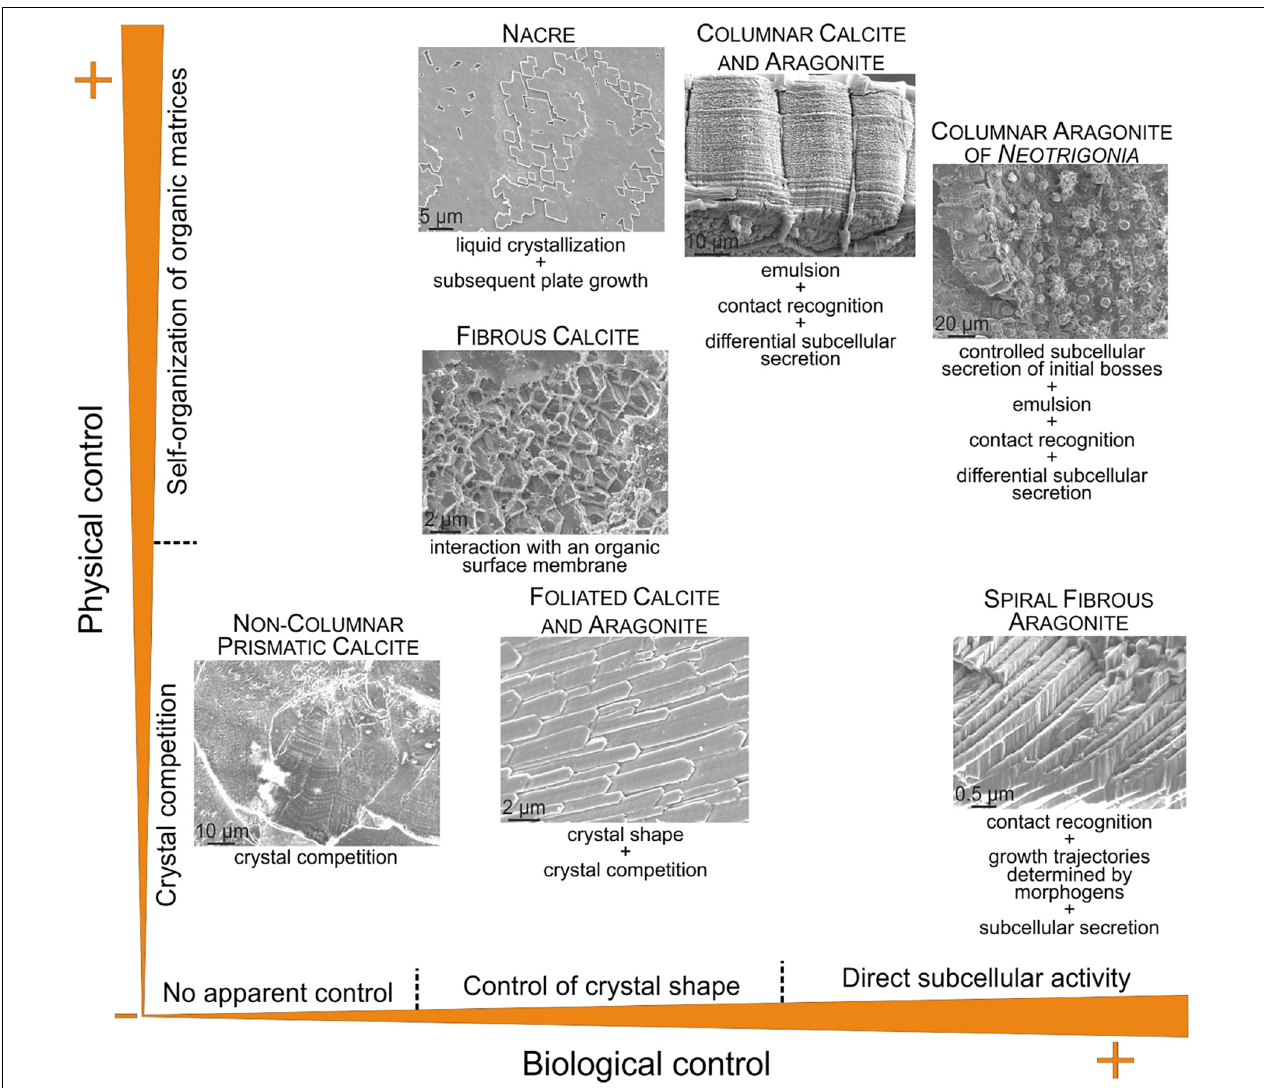
FIGURE 10 | Approximate position of selected microstructures discussed in the text according to the physical and biological influences on their fabrication. In the columnar calcitic and aragonitic microstructures (including the columnar aragonitic microstructure of Neotrigonia ), the aspects of calcite (with irregular outlines) and aragonite prisms (fibrous aggregates) suggest little to no control of the crystal shape. The microstructures represented correspond to the bivalves Pteria hirundo (nacre), Isognomon legumen (columnar prismatic calcite), Neotrigonia lamarckii (columnar prismatic aragonite), Mytilus galloprovincialis (fibrous calcite), Chama pellucida (prismatic, non-columnar, calcite) and Propeamussium dalli (foliated calcite), and to the gastropod Cuvierina columnella (helical fibrous